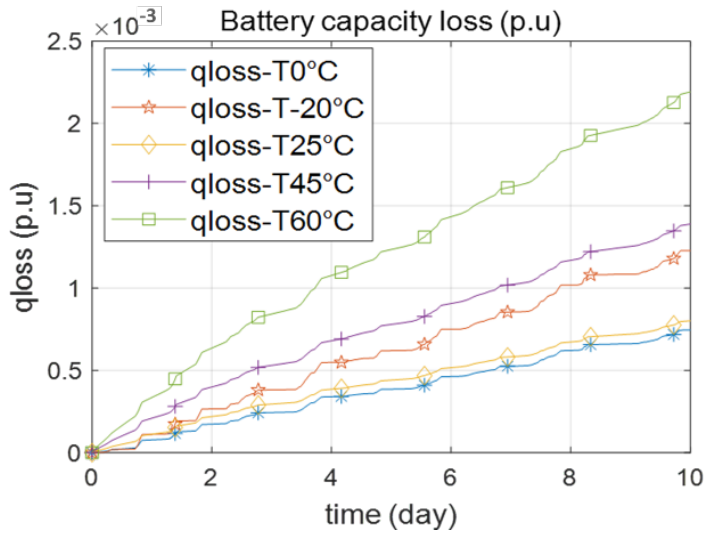
Figure 14. Battery capacity loss under extreme temperature conditions.